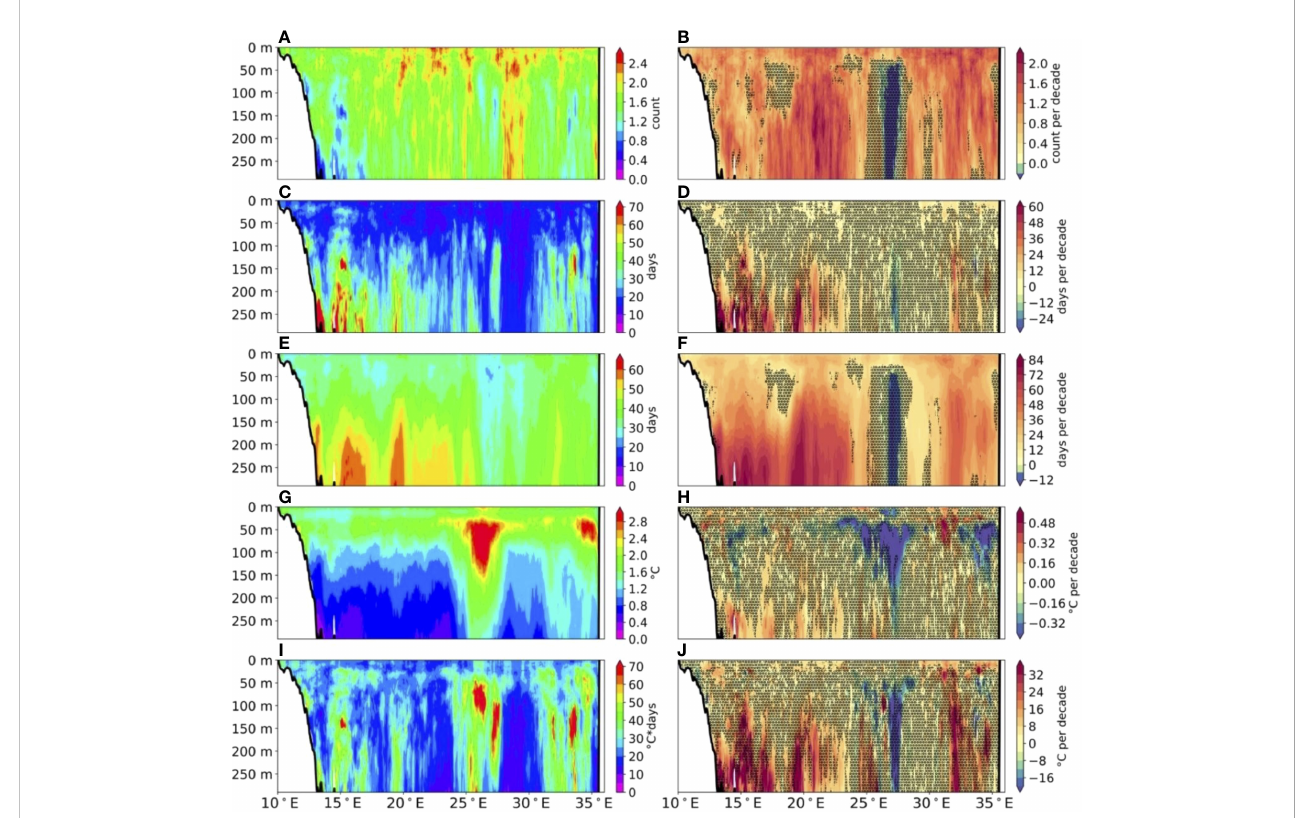
FIGURE 6 Vertical sections of means (left panels, A, C, E, G, I ) and linear trends (right panels, B, D, F, H, J ) over the period 1987-2019 of annual MHW frequency ( A, B, in count), duration ( C, D, in days), total days ( E, F, in days), maximum intensity ( G, H, in °C) and cumulative intensity ( I, J , in °C*days), as detected from MEDREA temperature in the upper 300 m, along the eastern latitudinal section (as displayed in Figure 1). The black line indicates the bathymetry. Black hatches indicate where trend values are not signi fi cant at the 95% con fi dence level based on a Mann-Kendall trend